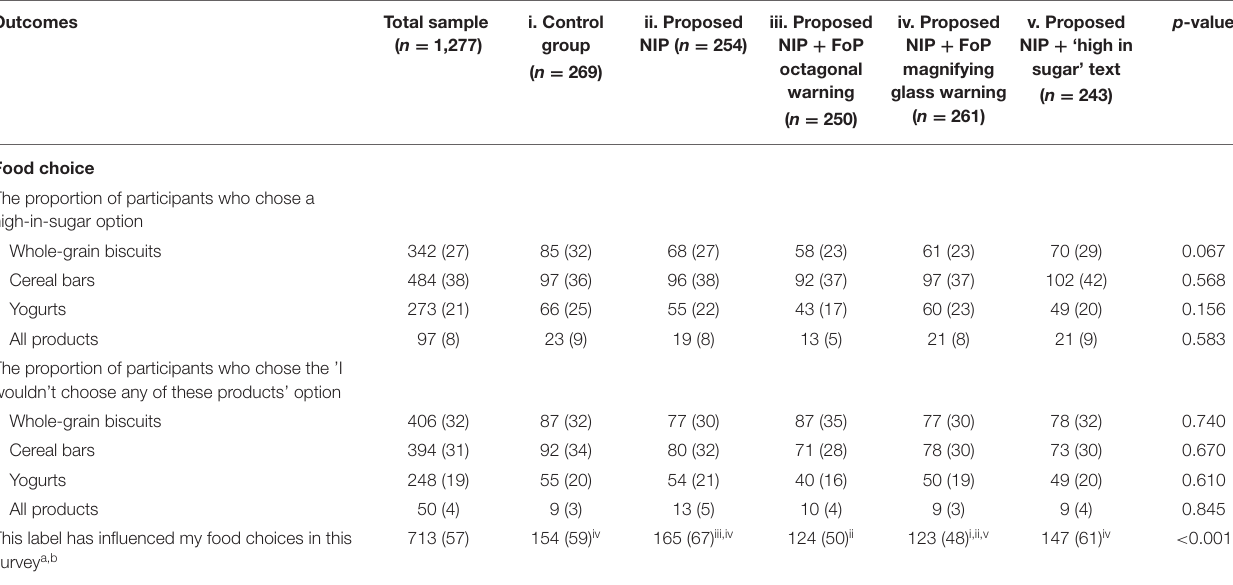
TABLE 4 | Participants’ food choices for high-in-sugar products and perceived influence of the label in their choices [n (%)], by study arm ( n = 1,277). Outcomes